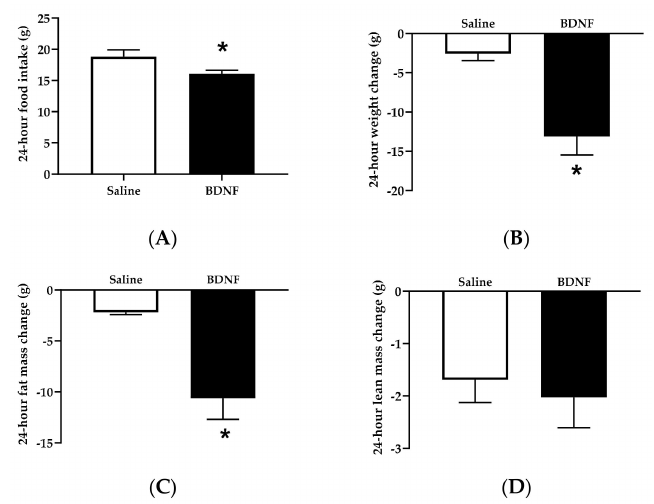
Figure 1. Food intake, body weight change, and body composition change in saline- or BDNF-treated rats. ( A ) Food intake, ( B ) body weight change, and body composition changes in ( C ) fat mass and ( D ) lean mass measured before and 24 hours after intracerebroventricular injections of saline or BDNF. Data are expressed as mean ± SEM, n = 10 per group, and unpaired two-tailed t-tests were used to compare between saline and BDNF treatment groups. * Represents significant di ff erences relative to saline-treated rats ( p <